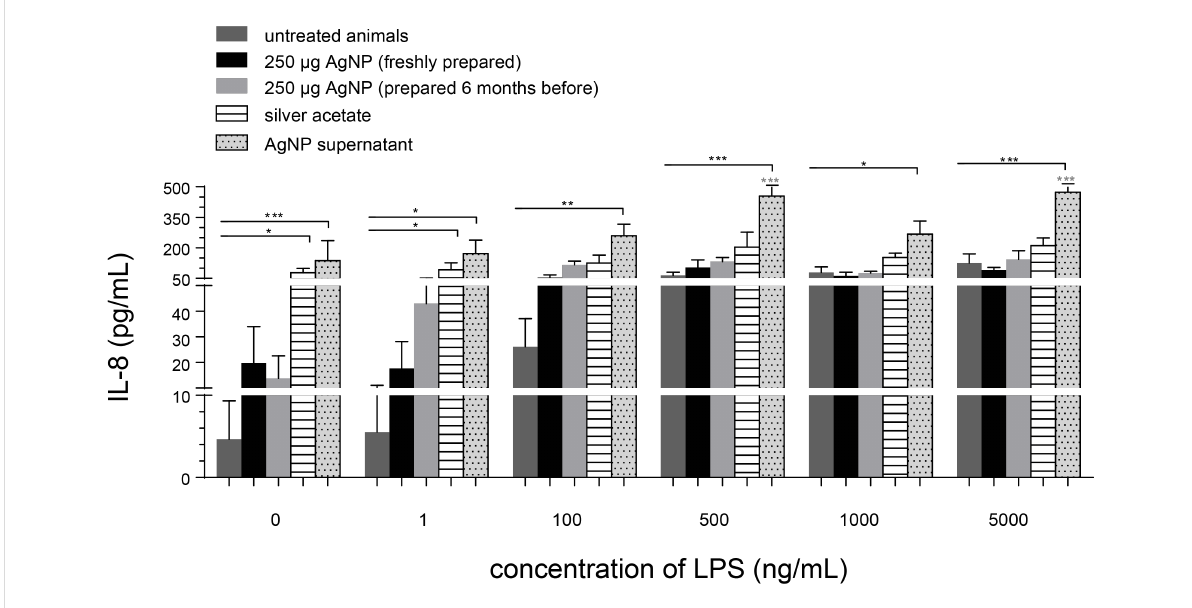
Figure 9: Release of IL-8 in the supernatant after 4 h of incubation of PCLS (from untreated animals or animals treated with 250 µg AgNP (freshly prepared or aged for six months), or silver acetate (250 µg Ag + ) or AgNP-free supernatant) with increasing LPS-concentrations in the tissue culture medium. The instilled volume always was 80 µL. Data are represented as mean ± SEM; n = 4–7; *,**,***: significantly different from PCLS exposed to 0 ng/mL LPS; *,**,***: significantly different from PCLS of untreated animals; p < 0.05 (*), p < 0.01 (**), p < 0.001 (***).